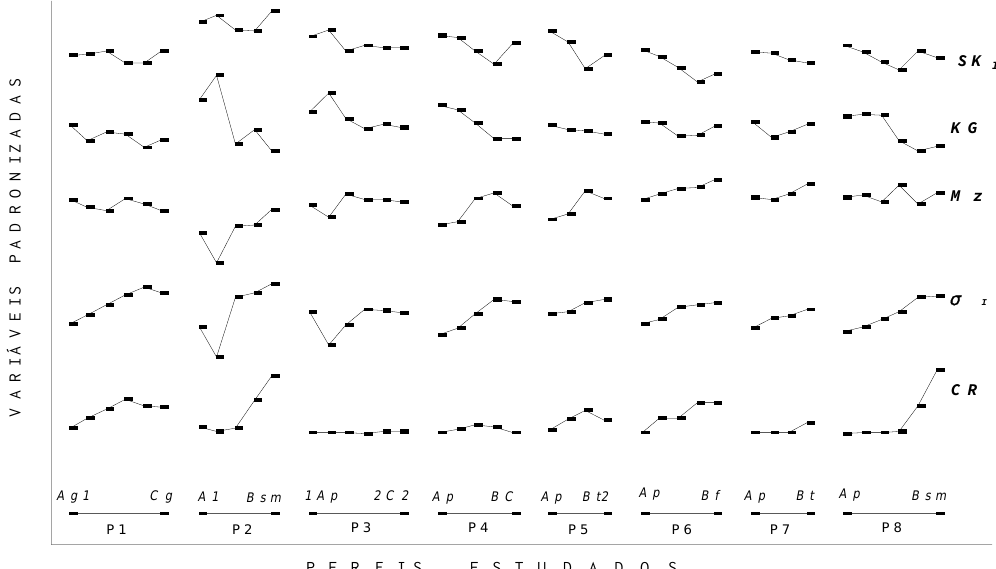
Figura 2. Compacidade relativa (CR) e medidas estatísticas da distribuição de freqüência (desvio-padrão gráfico inclusivo ( sssss I ), diâmetro médio na escala fffff ( Mz ), curtose gráfica ( KG ), e assimetria gráfica inclusiva ( SK I ))de tamanho de partículas da fração areia de cada um dos horizontes dos perfis (P i ) estudados. Da esquerda para a direita, para cada perfil, seqüência do horizonte mais superficial ao mais profundo. Para a comparação visual, os valores de cada variável (Quadro 3) receberam padronização de Student [(xi - m)/ sssss ], acrescidos de um valor inteiro constante de maneira a destacá-los das oscilações em torno da média igual a zero e desvio-padrão unitário causadas pela padronização. P1 - Gley Pouco Húmico; P2, P3 e P8 - Podzol Hidromórfico; P4, P5 e P7 - Podzólico Amarelo; P6 -